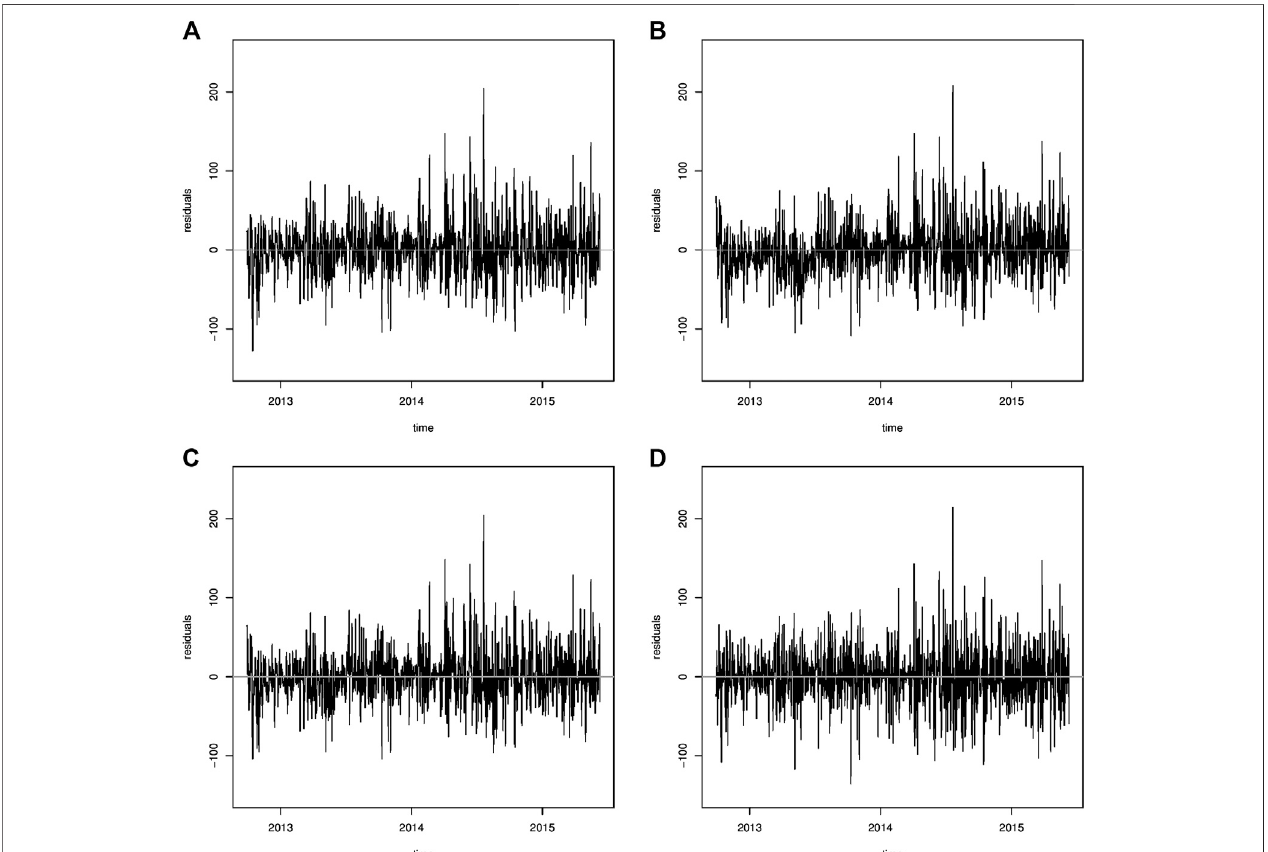
FIGURE 3 | Residual time series for the estimated Models (A – D) as labeled in Table 1.